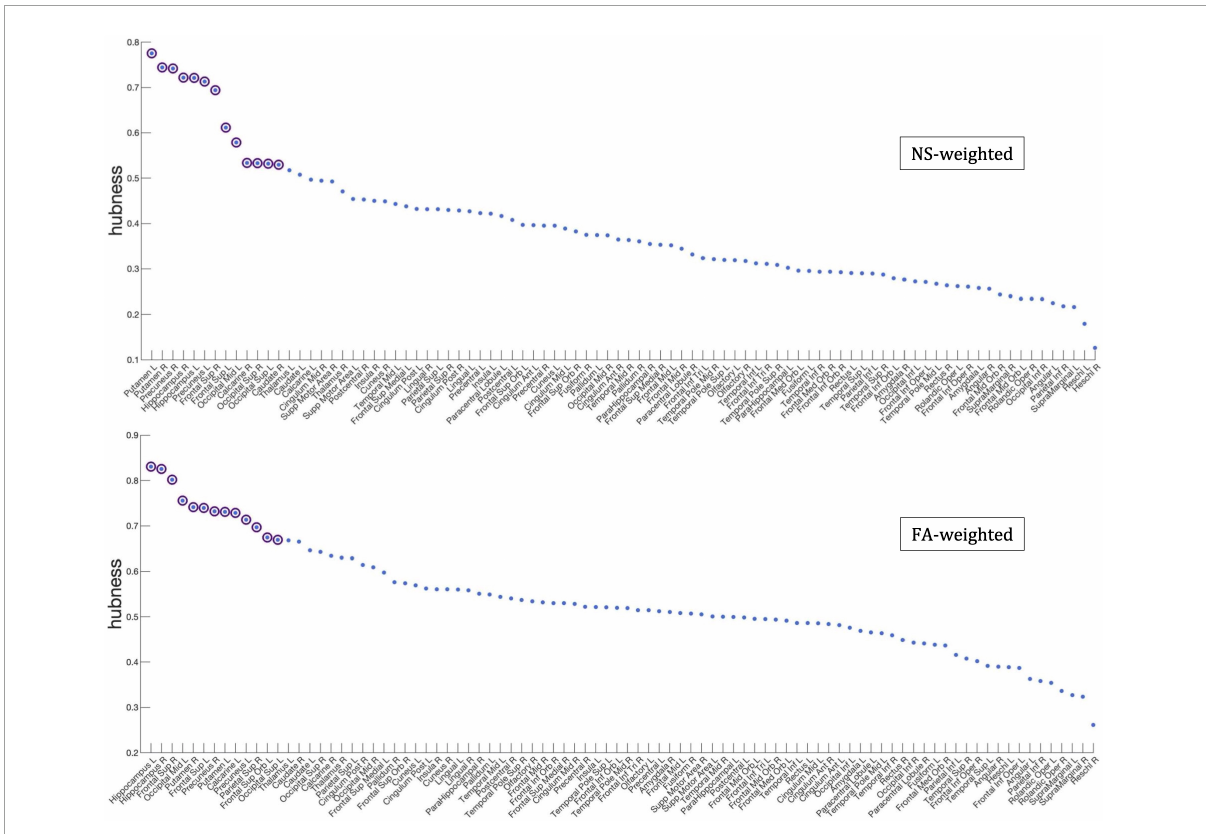
FIGURE7 Hubness scores for the network nodes for the NS-weighted (top) and FA-weighted (bottom) networks. The purple circles indicate nodes that are hubs for the respective